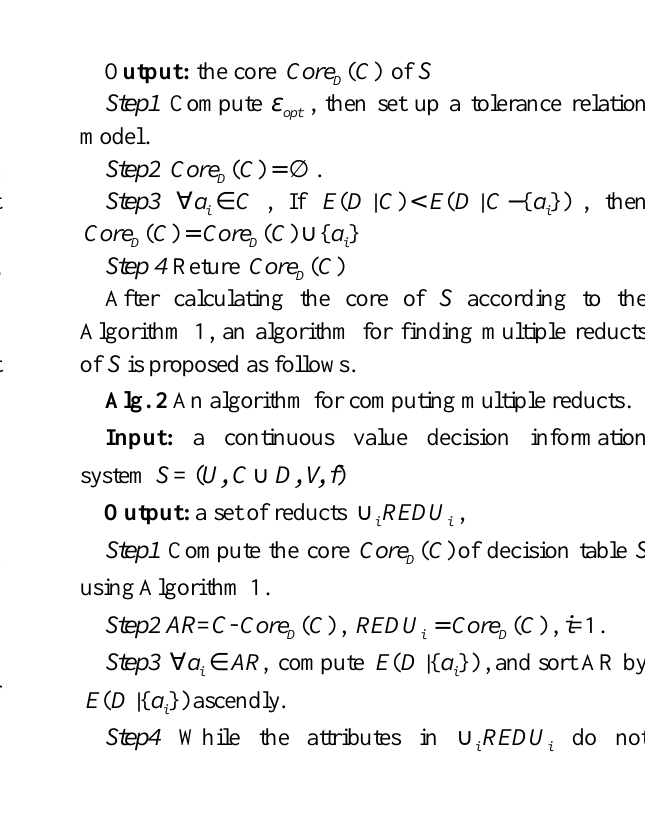
Fig 1.a Relationship between E ( C ) and e Fig 1.b Relationship between E ( D | C ) and